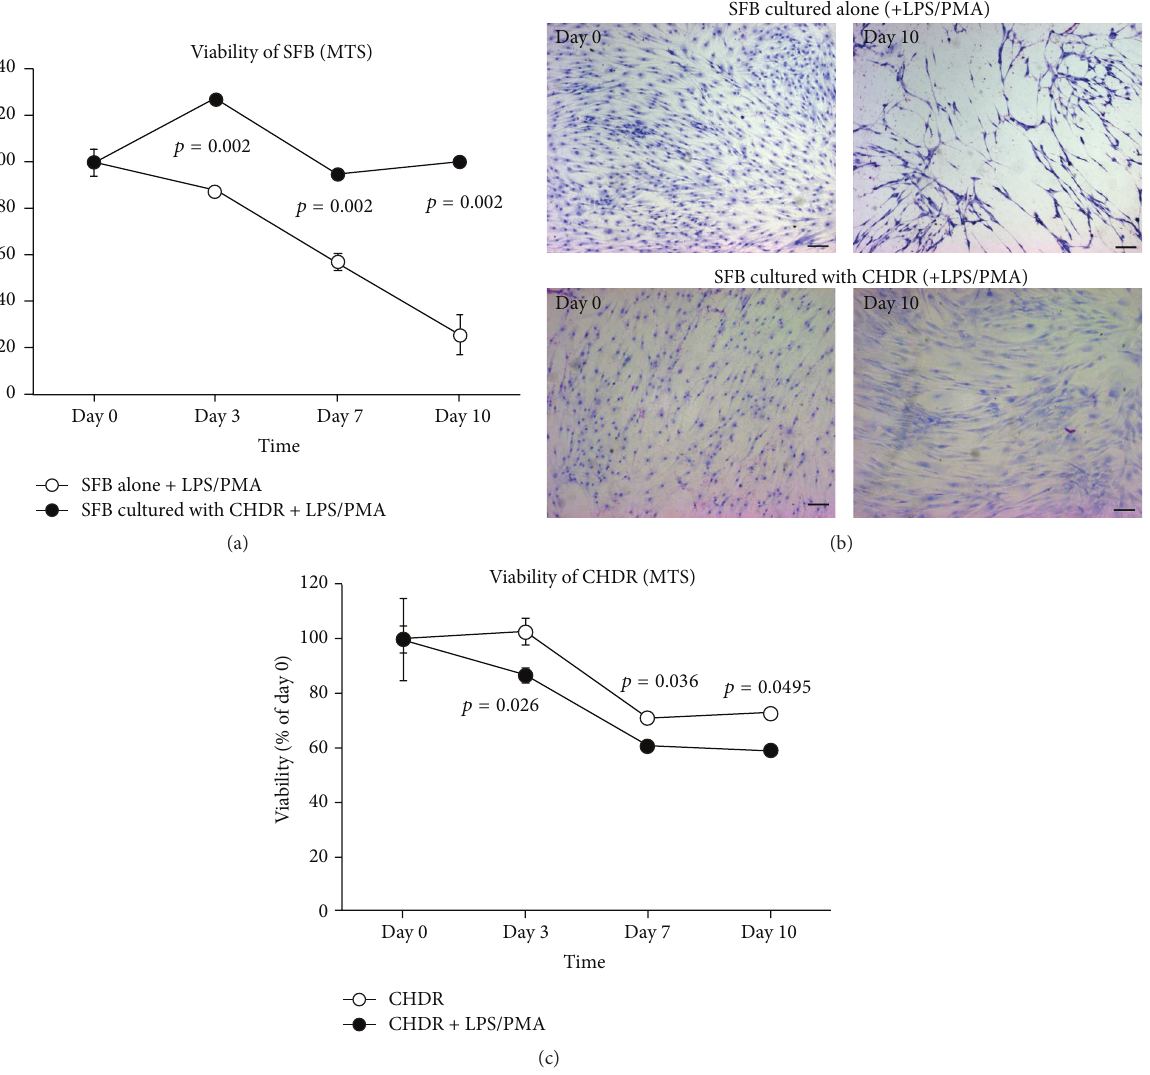
Figure 5: Viability of SFB was monitored using an MTS assay as shown in (a). While viability did not change over time in the presence of CHDR, a gradual decrease was observed during the incubation period in the absence of CHDR. (b) shows the correlating Giemsa staining for SFB cultures on cover slides confirming the MTS data. Scale bar 50 𝜇 m. The results of the MTS assay for CHDR in alginate beads are shown in (c). Metabolic activity slightly decreased from day 7 and was enhanced by adding LPS and